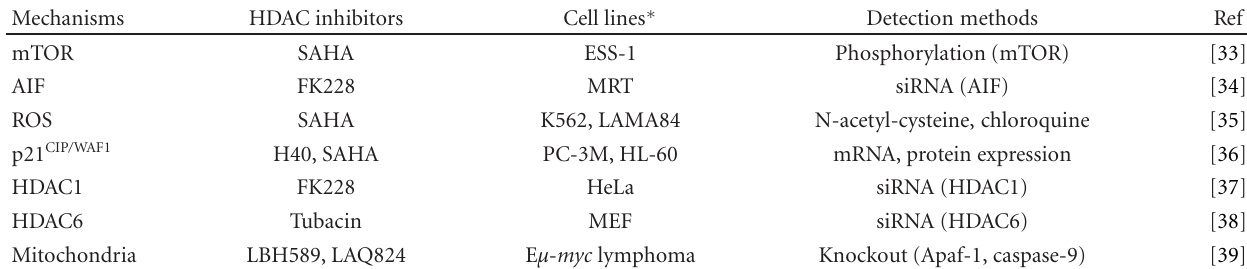
Table 3: E ff ects of HDAC inhibitor on the process of